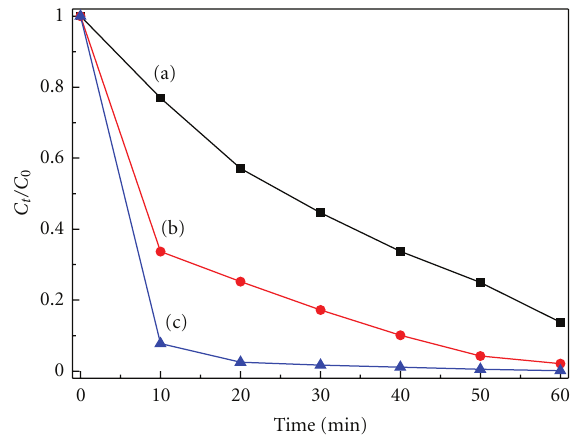
Figure 6: Photocatalytic activities of (a) Ag 3 PO 4 , (b) Ag 3 PO 4 / FLDH-1.6, and (c) Ag 3 PO 4 /FLDH-3 for ARG degradation under visible light irradiation.